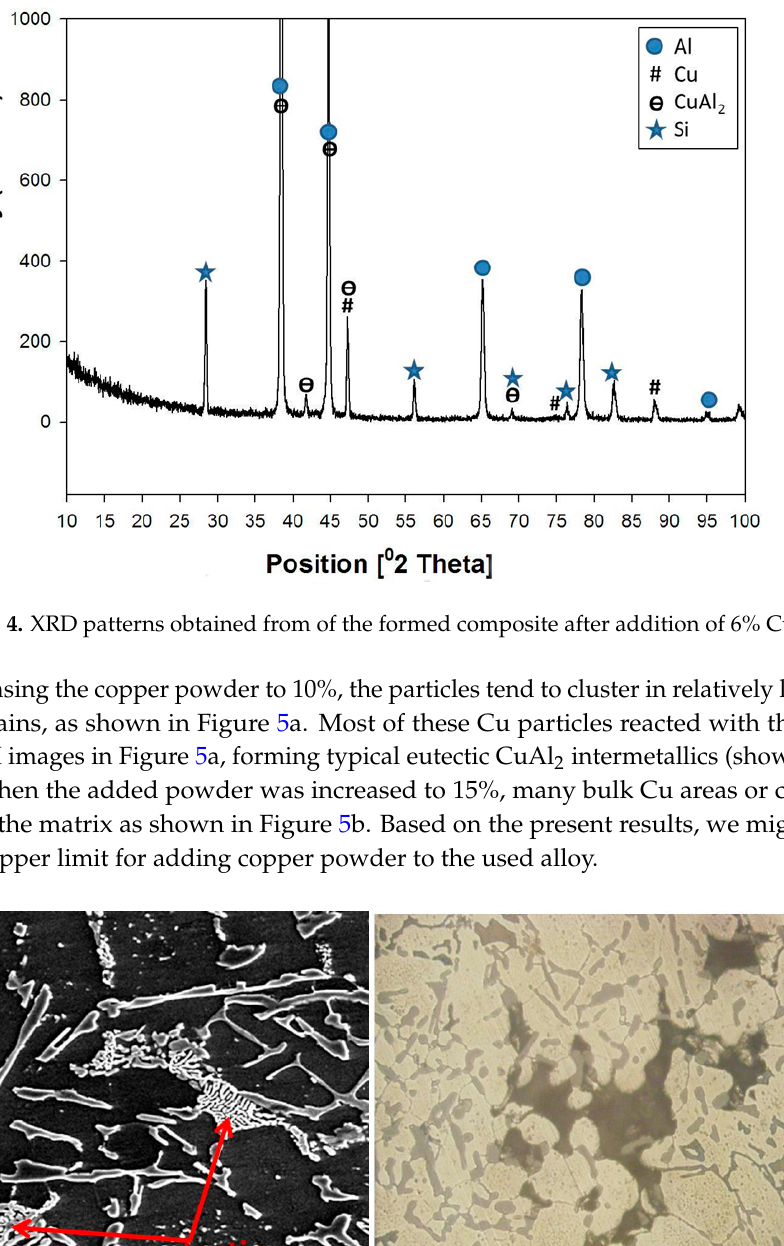
Figure 5. Microstructure of the formed composite after the addition of 10% and 15% Cu; ( a ) SEM Image (10% Cu) and ( b ) optical micrograph (15% Cu).